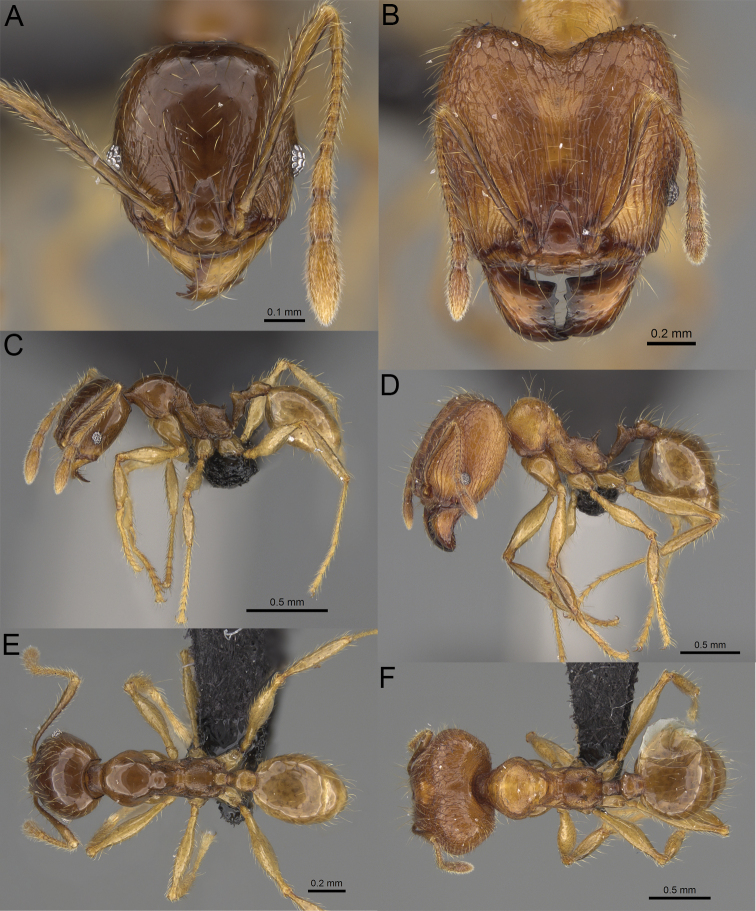
Pheidole
manantenina sp. nov., full-face view (A), profile (C), and dorsal view (E) of paratype minor worker (CASENT0487100) and full-face view (B), profile (D), and dorsal view (F) of holotype major worker (CASENT0923299).